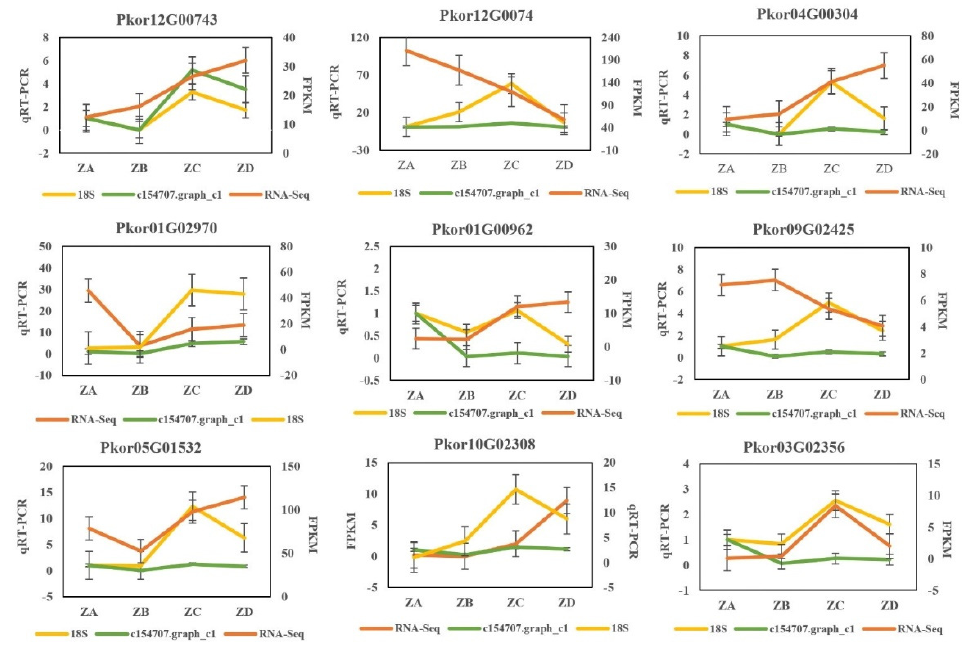
Figure 8. Verification results of 10 differential genes qRT-PCR before and after ovule fertilization of Korean pine.